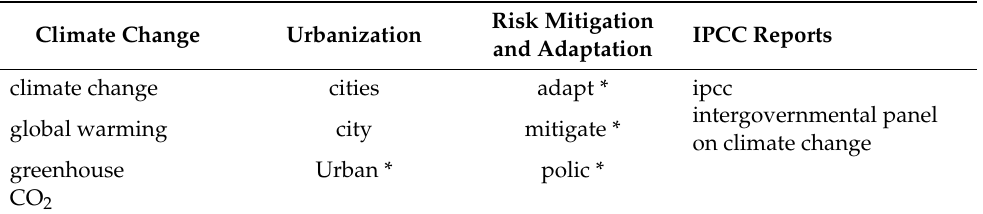
Risk Mitigation IPCC Reports and Adaptation intergovernmental panel on climate change